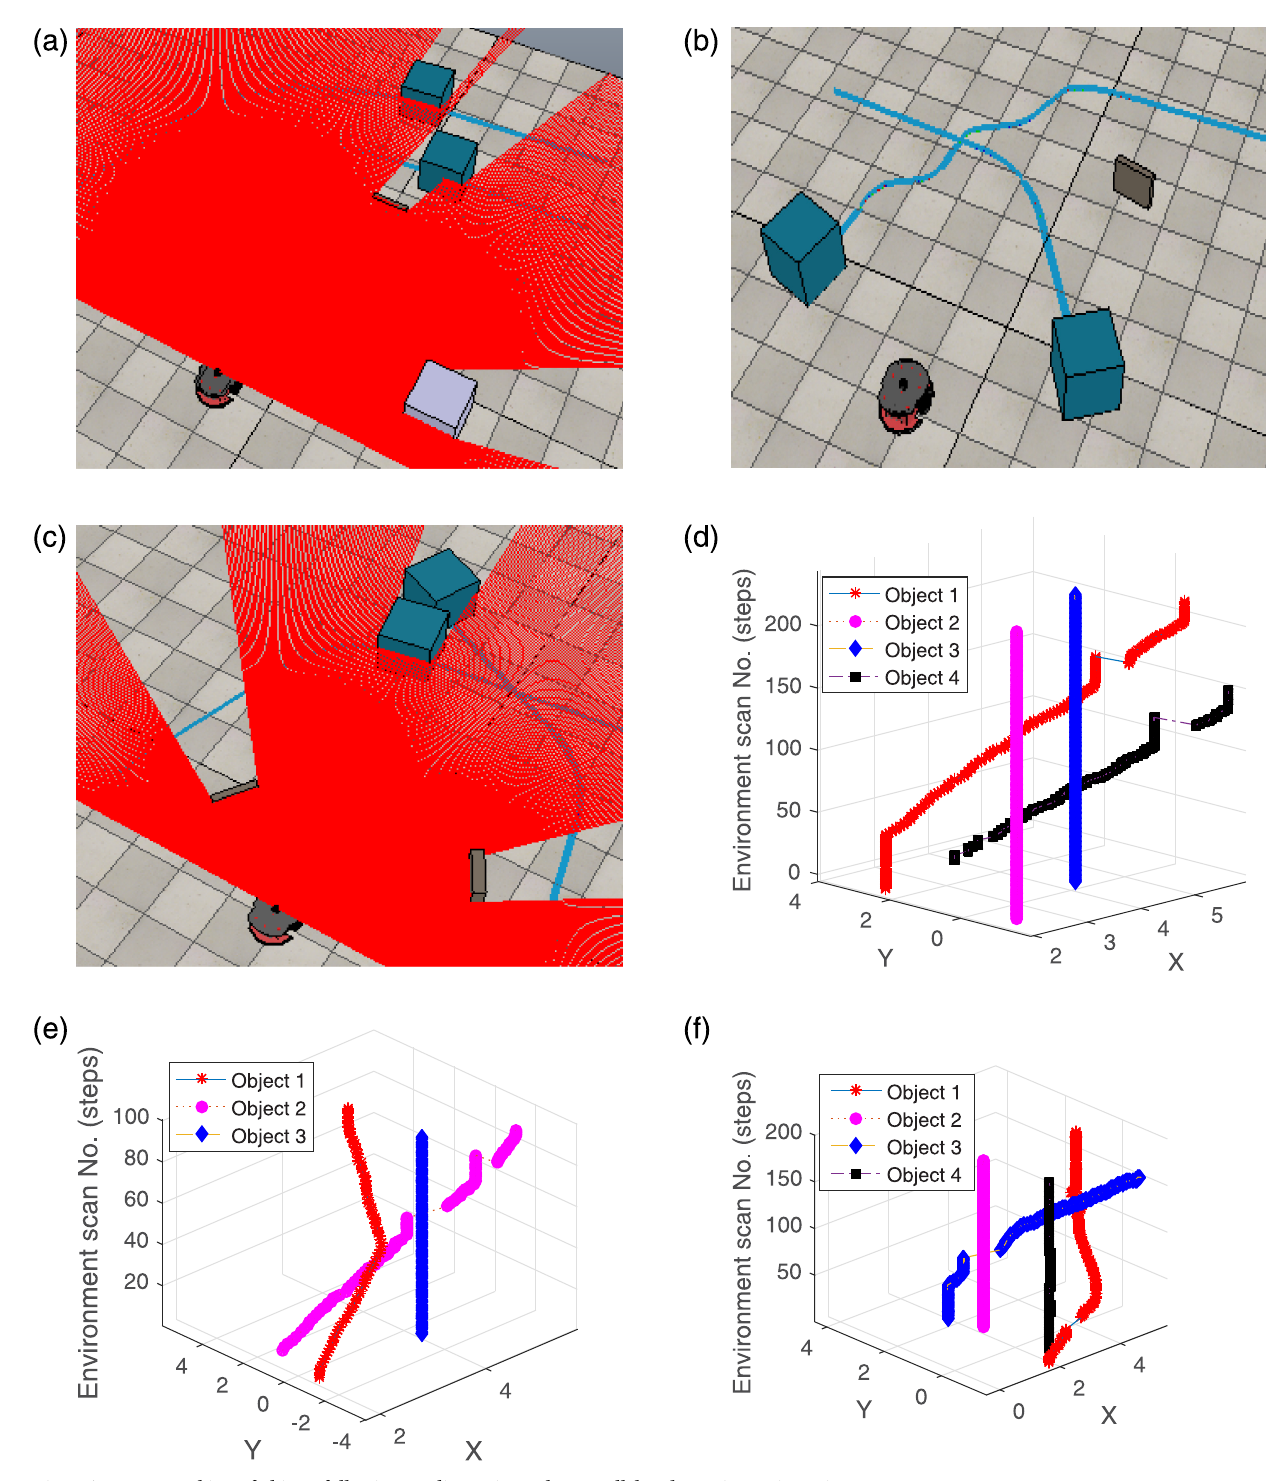
Fig 5. Accurate tracking of objects following nonlinear, irregular, parallel and crossing trajectories.